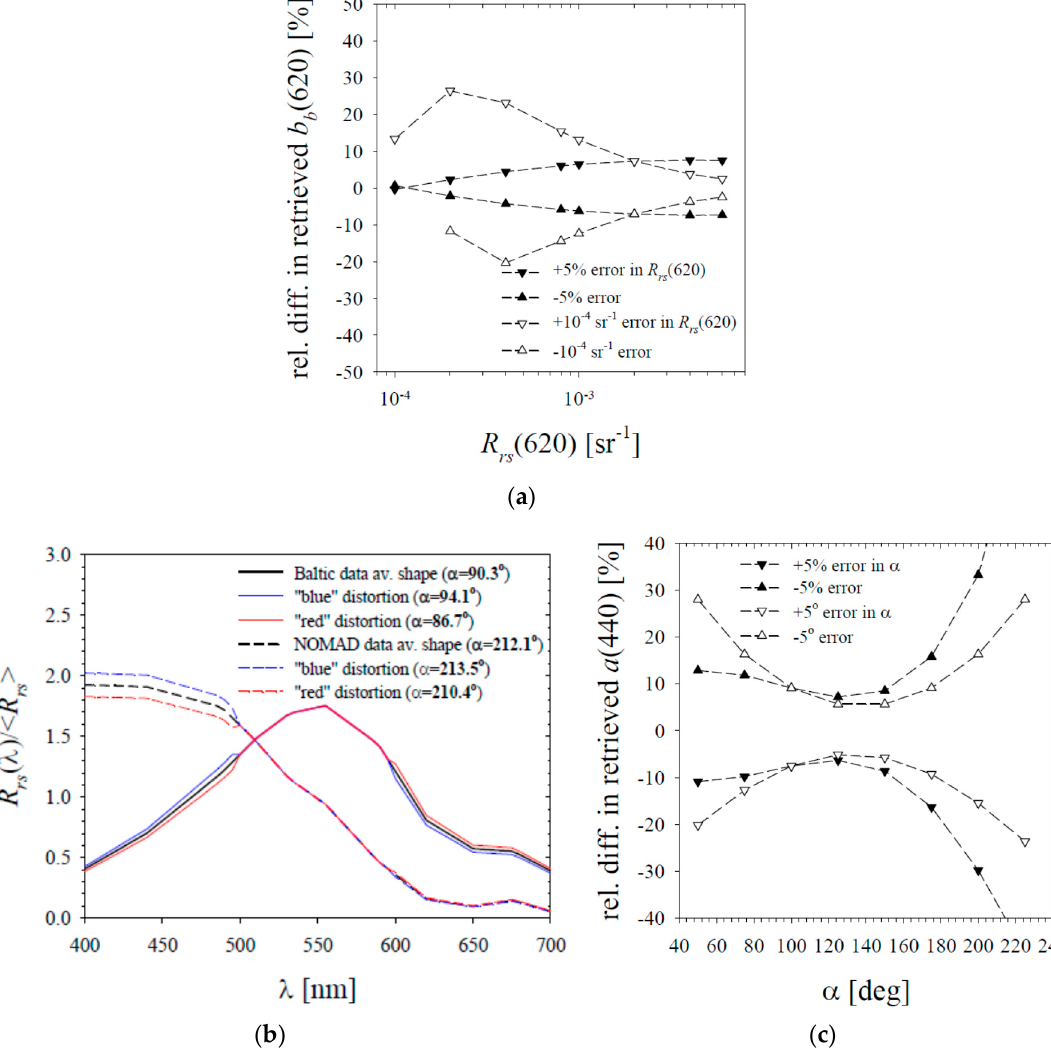
Figure 11. Results of calculation illustrating the discussion of the possible measurement error propagation related to the practical use of the empirical formulas presented here: ( a ) the relative differences in the retrieved values of b b (620) using Equation (12), calculated for the scenarios of different relative or absolute errors introduced in the input values of R rs (620); ( b ) average spectra of normalized reflectances R rs ( λ )/< R rs > for the Baltic Sea data and NOMAD data, and their “distorted” versions; the calculated values of the hue angle α are given in the caption; ( c ) the relative differences in the retrieved values of a (440) with use of Equation (16), calculated for different relative or absolute errors introduced in the input values of the hue angle α . The relative differences in panels a and c were calculated according to the following formula: (rel. diff. in retrieved quantity Y )[%] = 100*[f( X + ε )-f( X )]/f( X ), where Y —a dependent variable (either b b (620) or a (440)), X—an independent variable (either R rs (620) or α ), f(X)—an empirical formula tested (either Equation (12) or Equation (16)), ε —an error introduced in the independent variable.